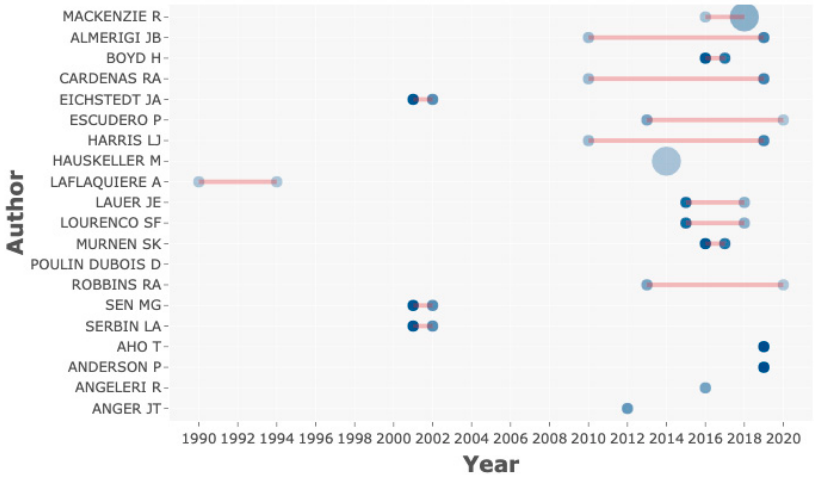
Figure 6. Comparison of the periods of publications according to author search.